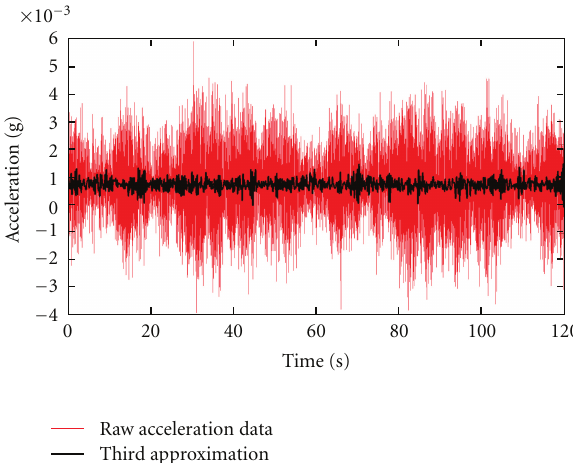
Figure 6: Raw acceleration signal (red) observed at sensor 9 in the benchmark structure versus the third approximation of the acceleration signal (black) used for damage detection.